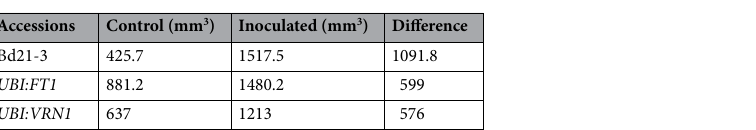
Figure 3. ( a ) Comparison of shoot (upper panel) and root (lower panel) phenotypes at 28 dpi between inoculated (B+) Brachypodium wild type Bd21-3 and transgenic lines UBI:FT1 , UBI:VRN1 and their respective controls (B−). ( b ) Comparison of growth parameters of inoculated Bd21-3 and transgenic lines with non- inoculated control plants. Standard errors are displayed for each bar graph. Independent Student t-test was used to determine statistical differences. *indicates significance ( p < 0.05). Each bar represents the mean of 5 replicates.